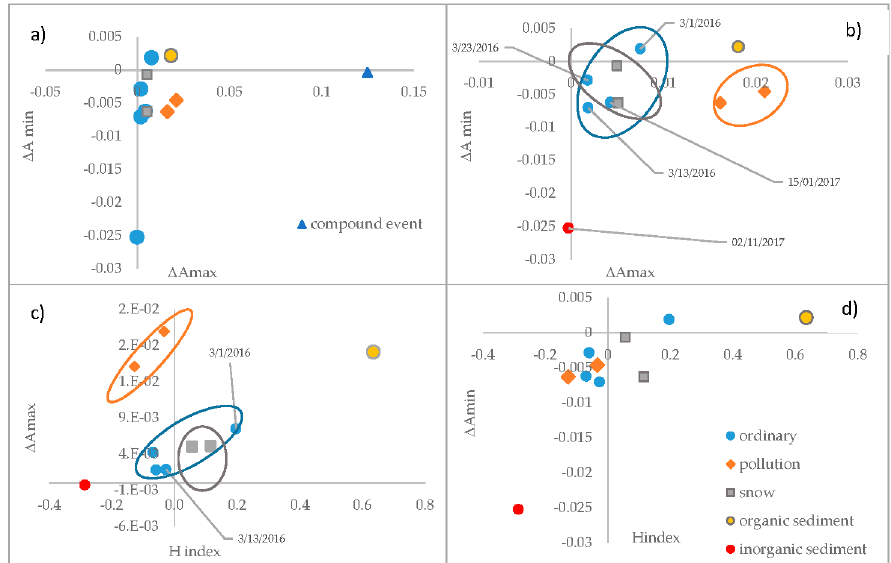
Figure 14. Comparisons in pairs of hysteretic indexes to better highlight the presence of events in groups that identify the different types of phenomena. ( a ) Δ Amax- Δ Amin relation; ( b ) Δ Amax- Δ Amin relation without a compound event; ( c ) h index- Δ Amax relation without a compound event; ( d ) h index- Δ Amin relation without a compound event